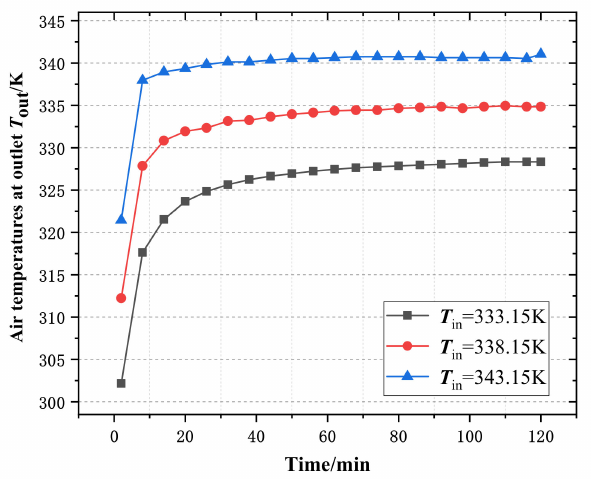
Figure 7. Variations of air temperatures at the outlet of dehumidifier with time at different inlet wet air